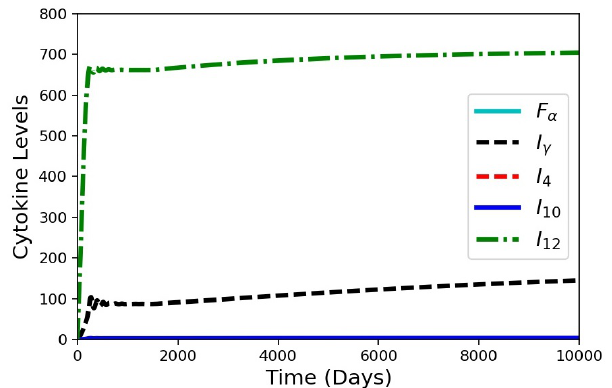
Figure 9. Simulation results for the cytokines from the in silico HIV co-infection experiment via T 0 cell depletion after 1500 days. The depletion results in increasing cytokine levels, except for I 4 . The values for F α , I 10 , and I 4 are all